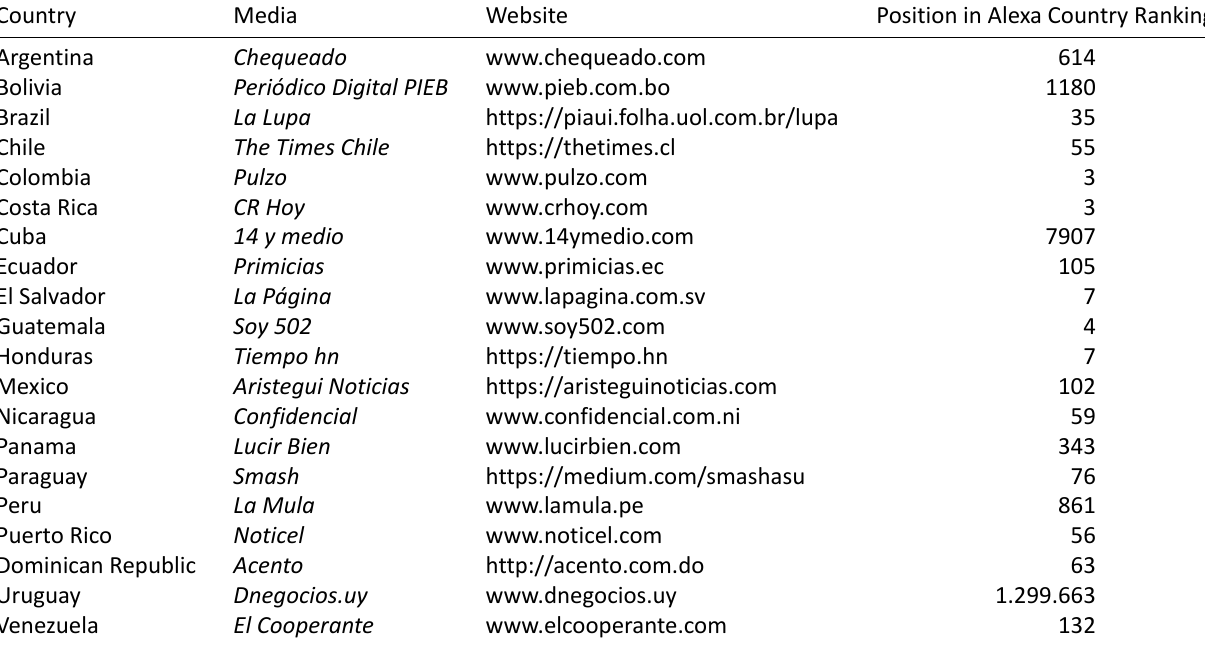
Table 4. Analysis